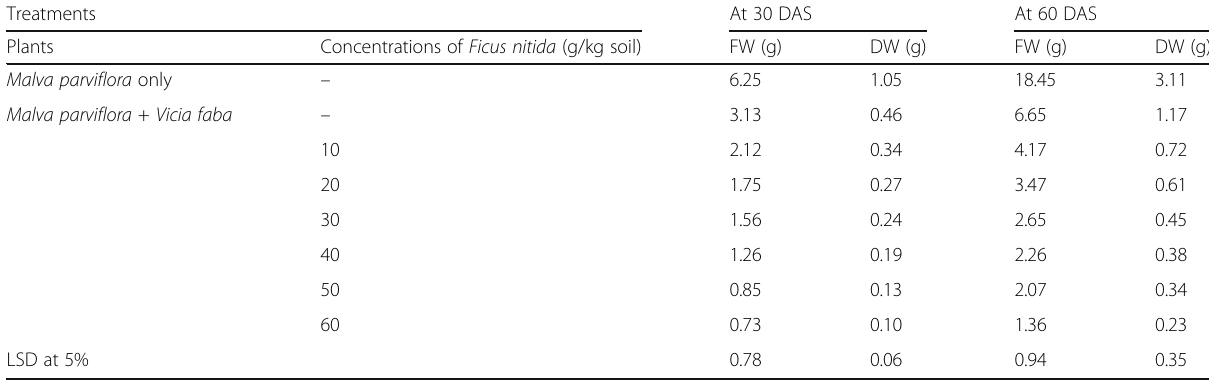
Table 2 Effect of Ficus nitida leaf powder on fresh and dry weight of broad leaved weed Malva parviflora associated with Vicia faba plants (average of the two seasons) Treatments At 30 DAS At 60 DAS